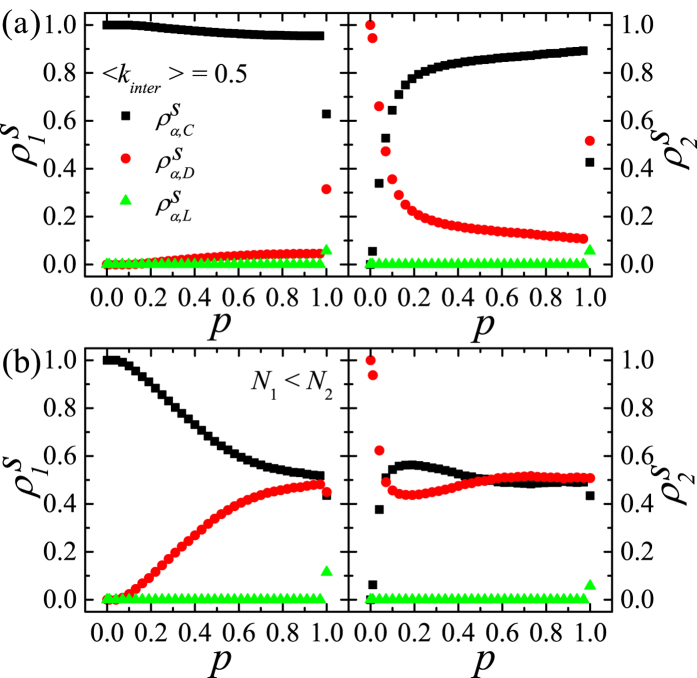
,  and  on the asymmetric DRN with 〈kintra〉 < 1 or N1 ≠ N2.r0 = 0.3 is used. (a) Plots of ,  and  against p (Left) and the same plots of ,  and  (Right) on the DRN with 〈kintra〉1 = 10 and 〈kintra〉2 = 40 for 〈kintra〉 = 0.5 and N1 = N2 = N = 16000. (b) The same plots as (a) on the asymmetric DRN against p with N1 = 16000, 〈kintra〉1 = 10 and with N2 = 32000, 〈kintra〉2 = 57 for ninter = N1.